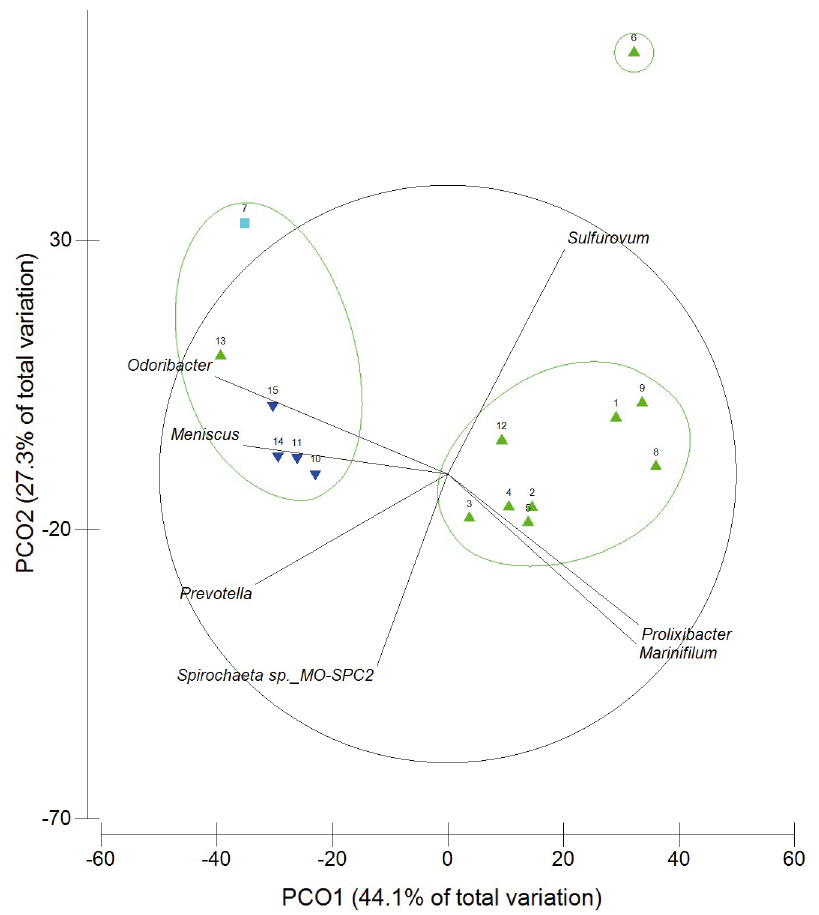
Fig. 4. Principal coordinate (PCO) analysis of flocculent matter samples. Indi- cated are sample clusters by 40% similarity (green line). Symbols and num- bers indicate sample and sample type; green triangles: bulk flocculent matter, blue triangles: bacterial mat samples, square: gaseous sample. PCO vectors (Pearson correlation, solid lines) of high abundance genera are